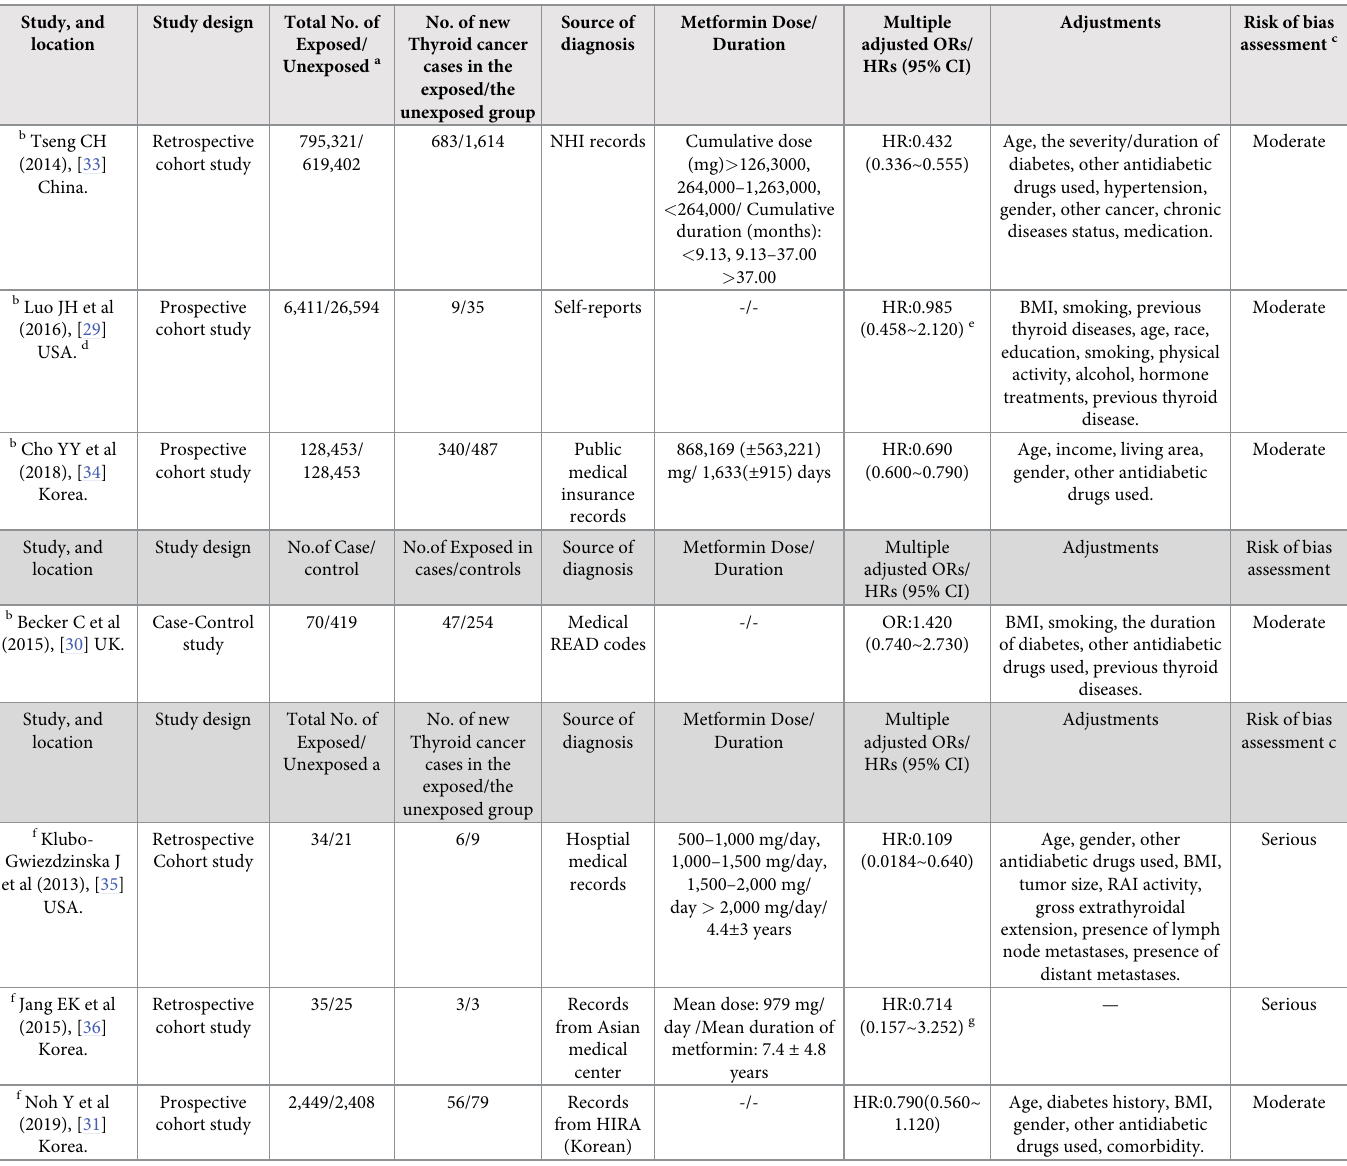
Table 1. Characteristics of studies included in the systematic